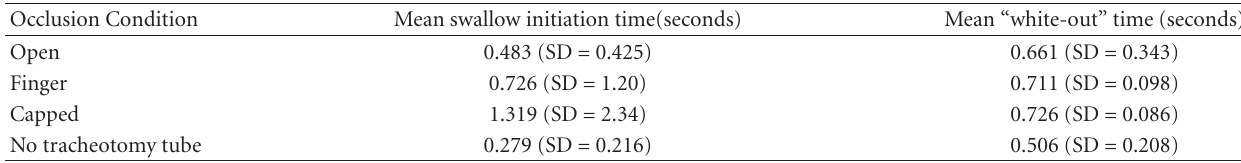
Table 4: Durational measurements by occlusion